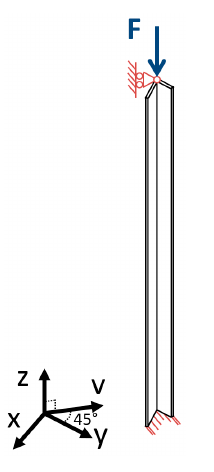
Figure 3. Diagram of a pinned–fixed column under compression.